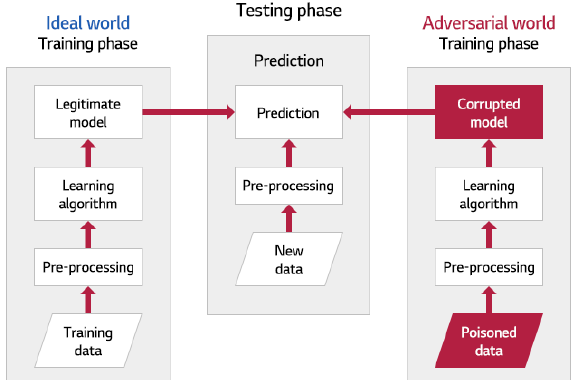
Figure 16. Procedure of poisoning attacks. Poisoning attacks change the probability distribution of the original training data by injecting malicious data into the training data during the training stage to reduce the prediction accuracy of the model.